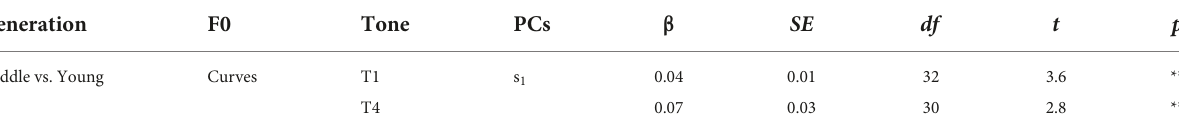
TABLE 5 Summary of linear mixed-effects modeling for F0 curves. Generation F0 Tone PCs